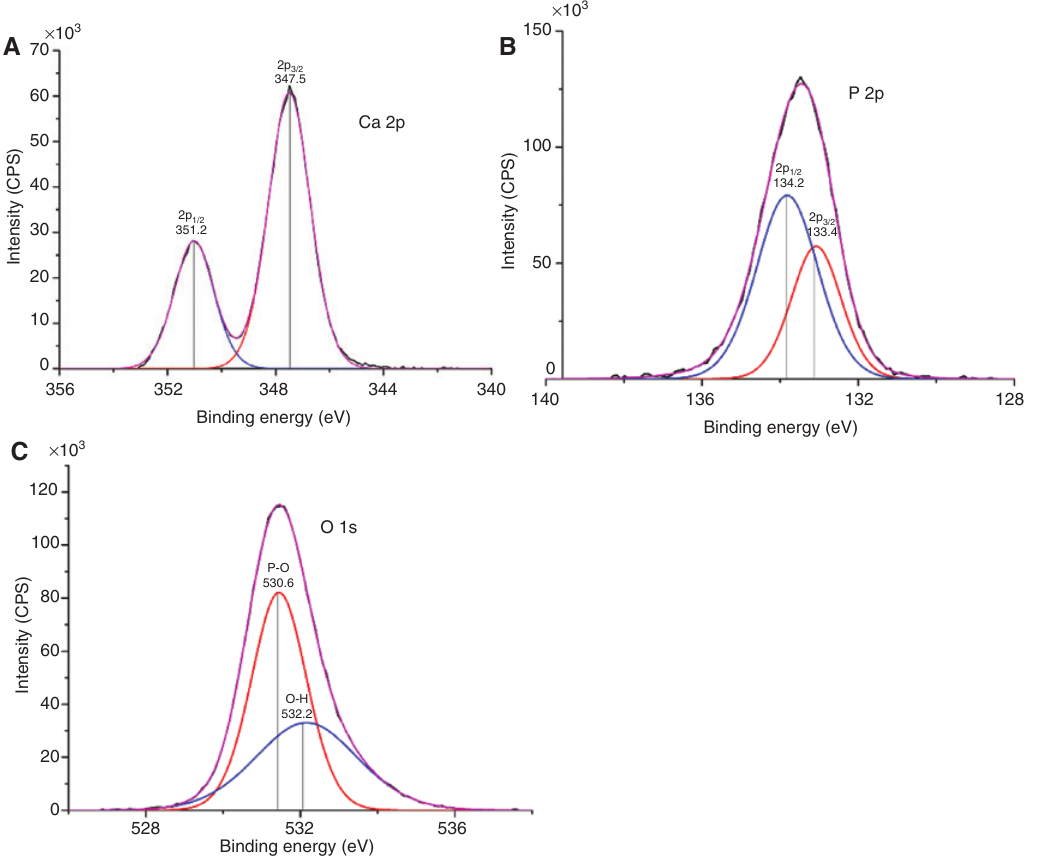
Figure 8: XPS spectra of (A) Ca 2p, (B) P 2p and (C) O 1s for phase-pure hydroxyapatite nanorods of sample 1, synthesized with the help calcium nitrate and diammonium hydrogen phosphate precursors via co-precipitation